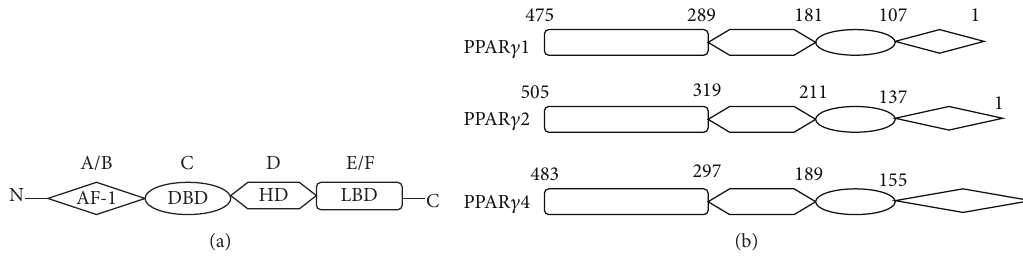
Figure 1: Schematic structure of peroxisome proliferator-activated receptor- 𝛾 and its protein isoforms. A/B, C, D, and E/F indicate the N- terminal A/B domain containing a ligand-independent AF-1, the DNA-binding domain, the hinge region, and the C-terminal LBD containing AF-2,respectively.AF-1isresponsibleforphosphorylation,whileAF-2promotestherecruitmentofcoactivatorsforgenetranscription.PPAR: peroxisome proliferator-activated receptor; AF: activation function; DBD: DNA-binding domain; HD: hinge domain; LBD: ligand-binding domain. Figure adapted from [13].